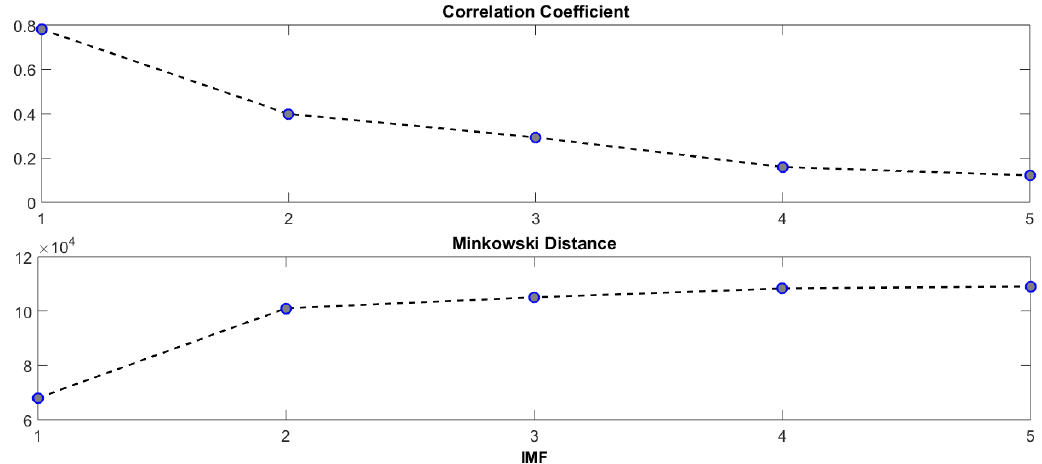
Figure 5. The values of correlation coefficient, Minkowski distance for the five IMFs.